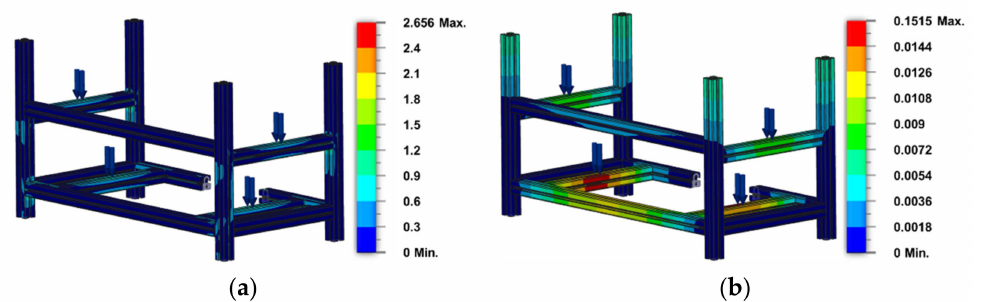
Figure 5. Contour Structural Analysis of Prior Study: ( a ) Von Mises Stress Contour; ( b ) Displace- ment Contour.